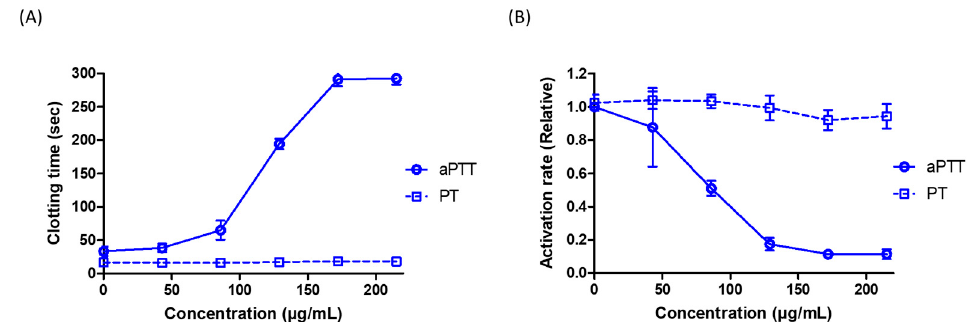
Figure 5. Anticoagulant activity of GdAPs on activated partial thromboplastin (aPTT) and prothrom- bin (PT). ( A , B ) Effect of GdAPs concentration on the clotting time and ( B ) activation rate of aPTT and PT. The vertical bars correspond to the standard deviation of three independent measurements ( n =